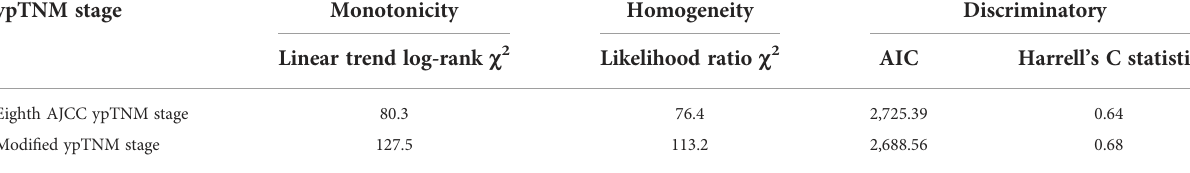
TABLE 2 Comparison of eighth AJCC TNM stage and modi fi ed ypTNM